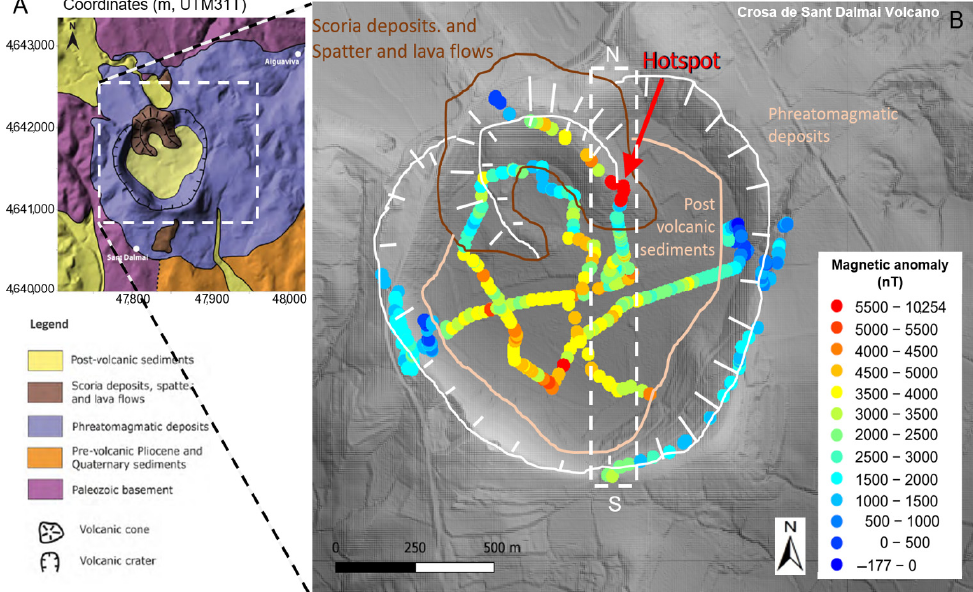
Figure 9. ( A ) Geological map of the crater of the Crosa de Sant Dalmai volcano by Bolós et al., 2012 [82]. ( B ) Representation of the measurements performed with the on-ground equipment survey, showing the magnetic anomaly superimposed with the structure with the main different elements: phreatomagmatic deposits, scoria deposits, spatter, and lava flow, as well as the post-volcanic sediments. The rectangle in the dashed lines shows the transect for the modeling.